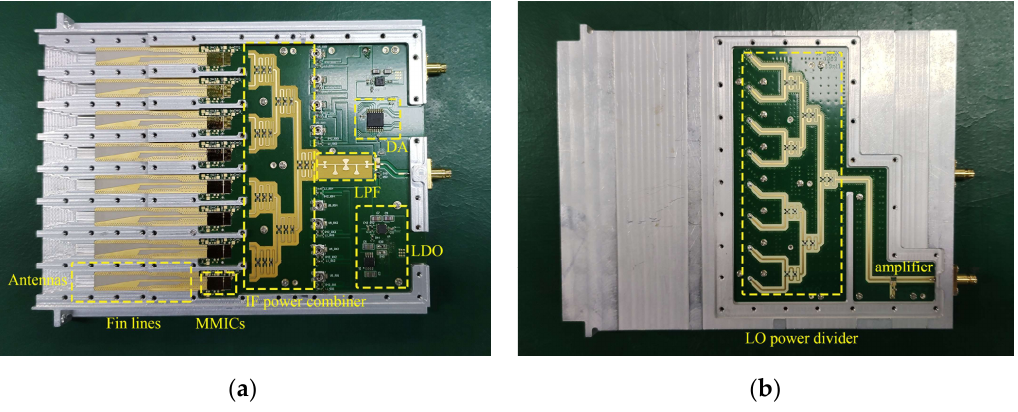
Figure 11. Photograph of the phased array receiver front end: ( a ) front side; ( b ) back side.